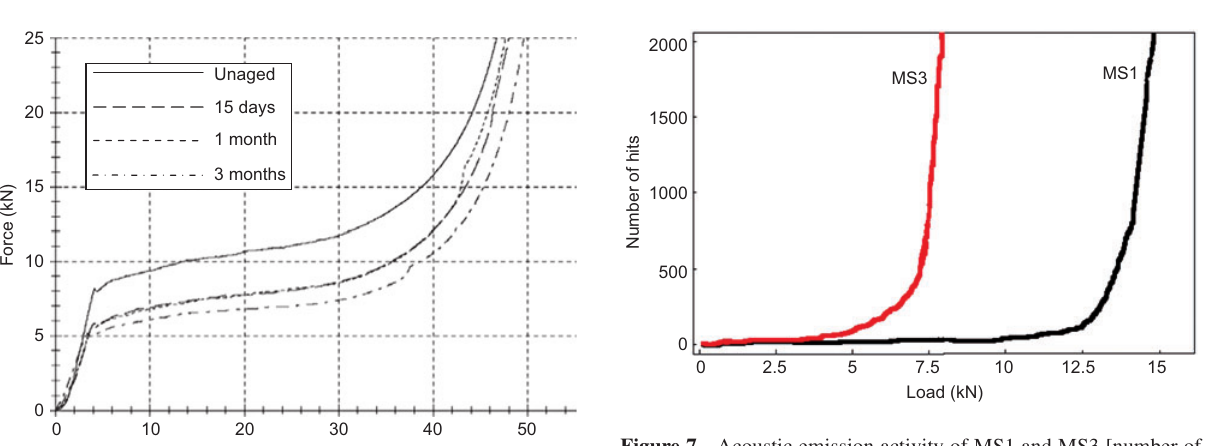
Figure 7 Acoustic emission activity of MS1 and MS3 [number of hits vs. load (kN/10)].